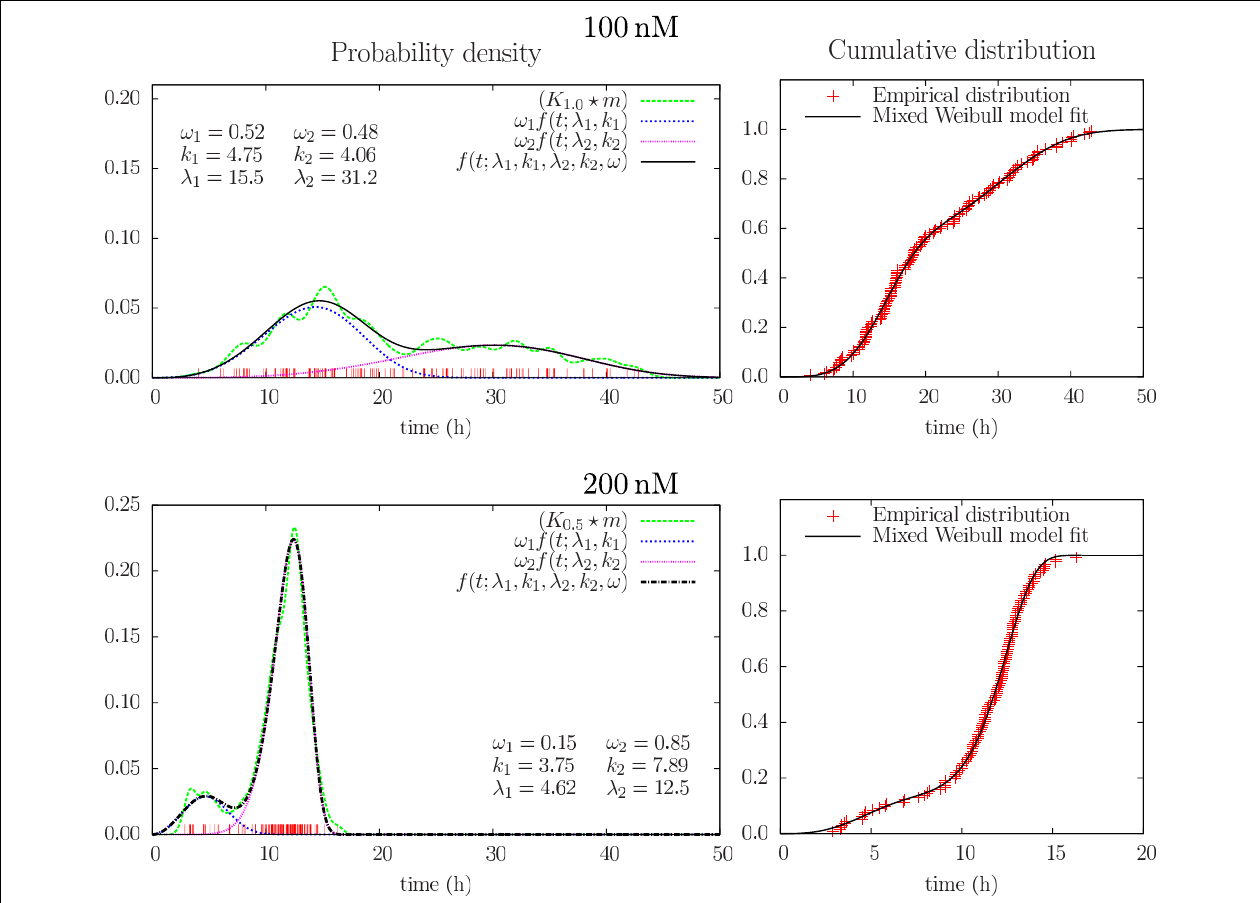
FIGURE 5 | Results from mixed Weibull analysis giving estimates of distributions of lifetimes of BC3H1 cells after YTX exposure at concentrations 100 and 200nM . The parameters for the mixed Weibull distribution ( k and (cid:21) ) result from model fit to the empirical cumulative distribution (right). Red vertical bars indicate individual observations (samples). The smoothed histograms K 1.0 (cid:2) m and K 0.5 (cid:2) m [cf Eq. (3)] are here for visual control and illustration.